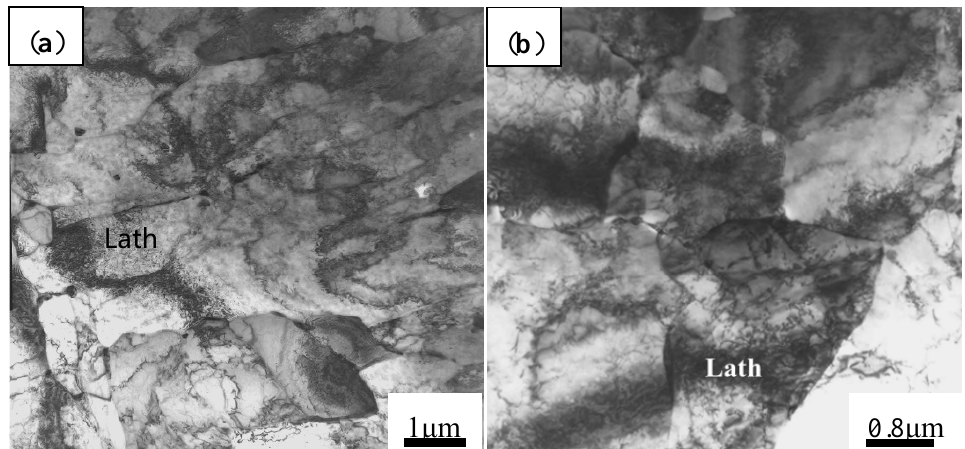
Figure 15. The TEM micrographs of Nb–Ti micro-alloyed steel at di ff erent conditions: ( a ) 1050 ◦ C and